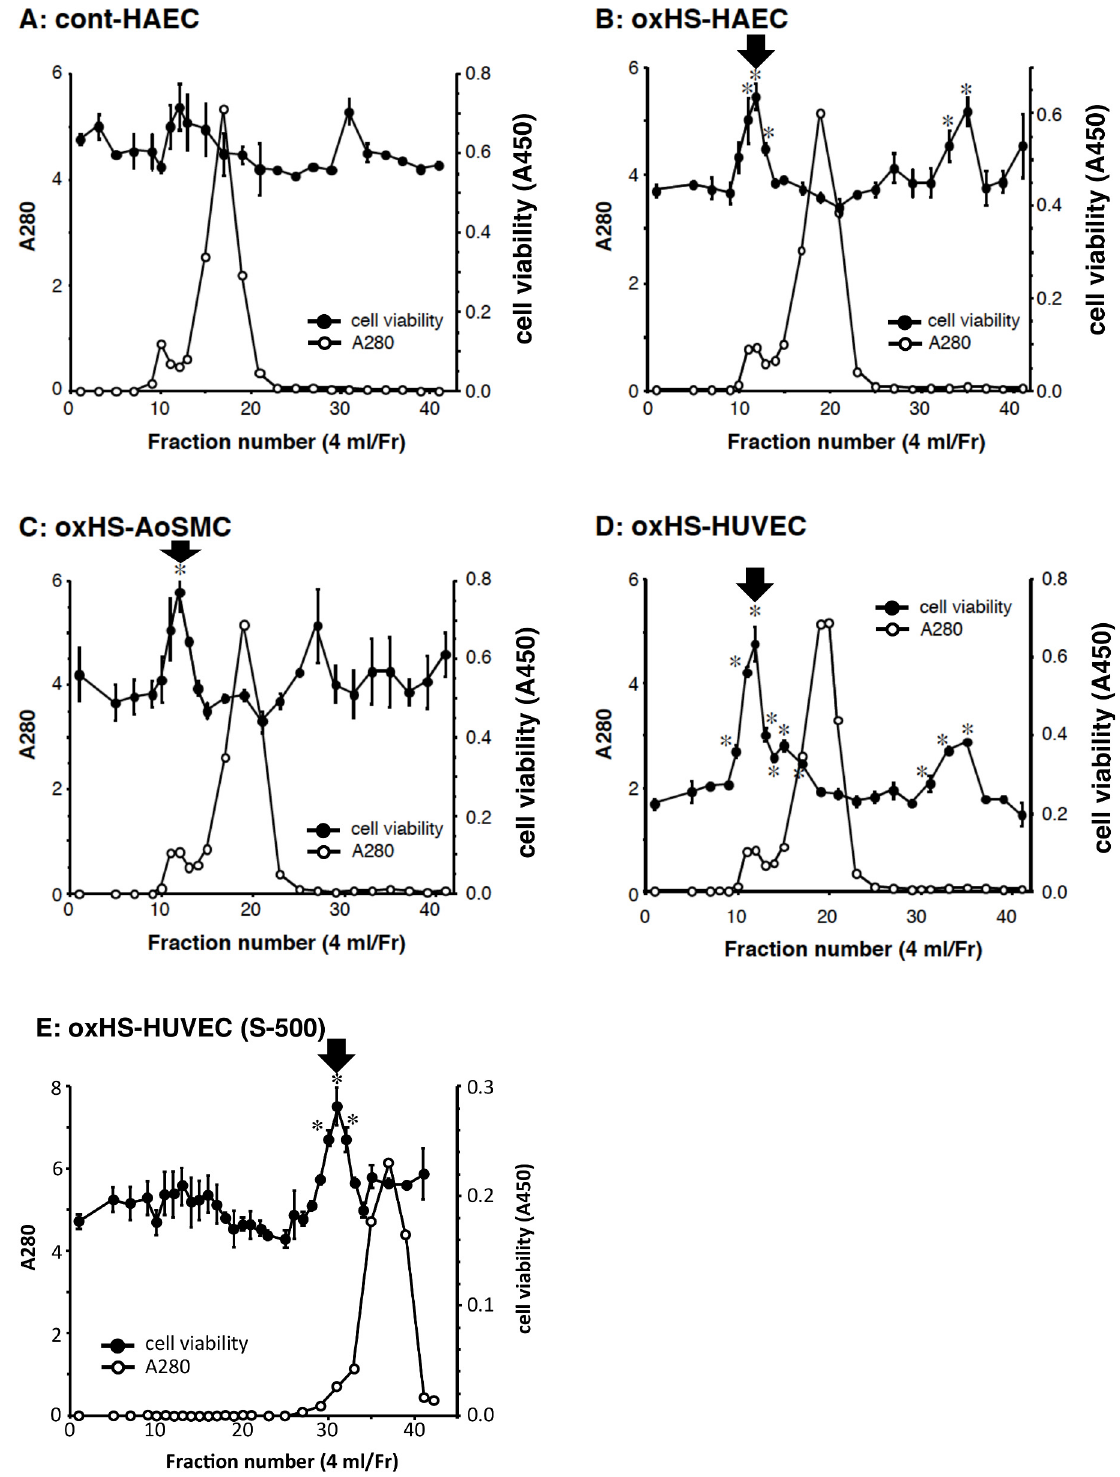
Fig 1. Effects of oxidized human serum components on vessel cell viability. A-D. Control ( A ) and oxidized human serum ( B-D ) were fractionated by Sephacryl S-300 gel chromatography, and protein contents were determined by absorbance at 280 nm. HAEC ( A, B ), AoSMC ( C ), and HUVEC ( D ) were treated with each fraction (10%) for 48h, and the viability was measured by WST assay, as described under “ Materials and methods ” . The maclomolecule proliferator for vessel cells at Fr.12 is indicated